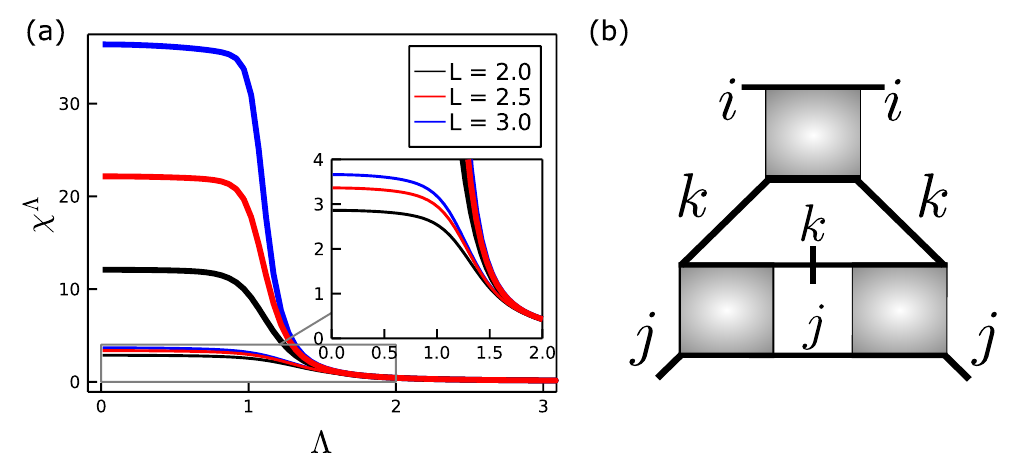
Figure 7: (a) Ferromagnetic Heisenberg model on the pyrochlore lattice for T = 0.5, = 0.685 observed in Fig. 8: Flow of the uni- well below the critical temperature T c form susceptibility χ Λ obtained in the one-loop (thick) and two-loop (thin) PMFRG as a function of the cutoff Λ for different maximum vertex lengths L . (b) Two-loop contribution to the right hand side of the flow equation for Γ where a ladder diagram (with external site indices k , j ) is inserted into the RPA channel (with external site indices i , j